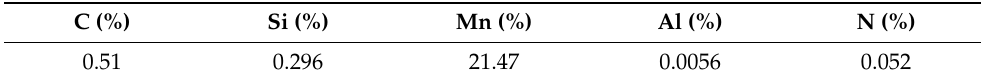
Table 1. TWIP steel chemical composition, wt% *.